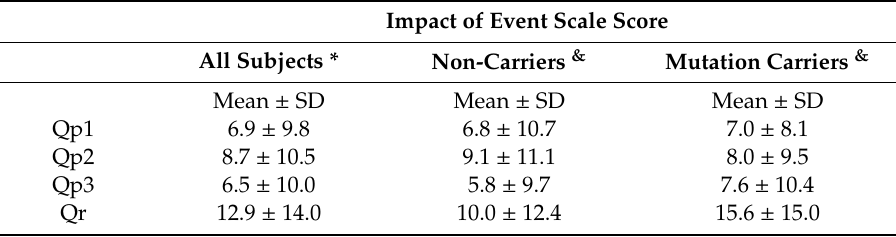
Table 4. Impact of Event Scale score over